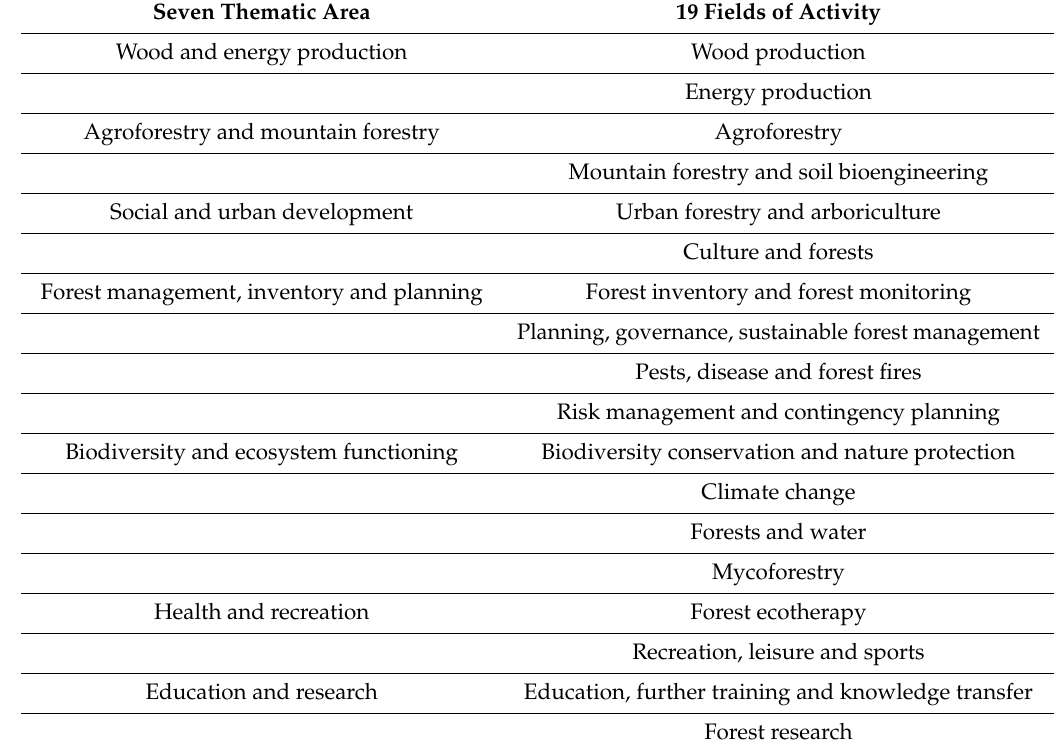
Table 2. Green forest jobs thematic area and fields of activity